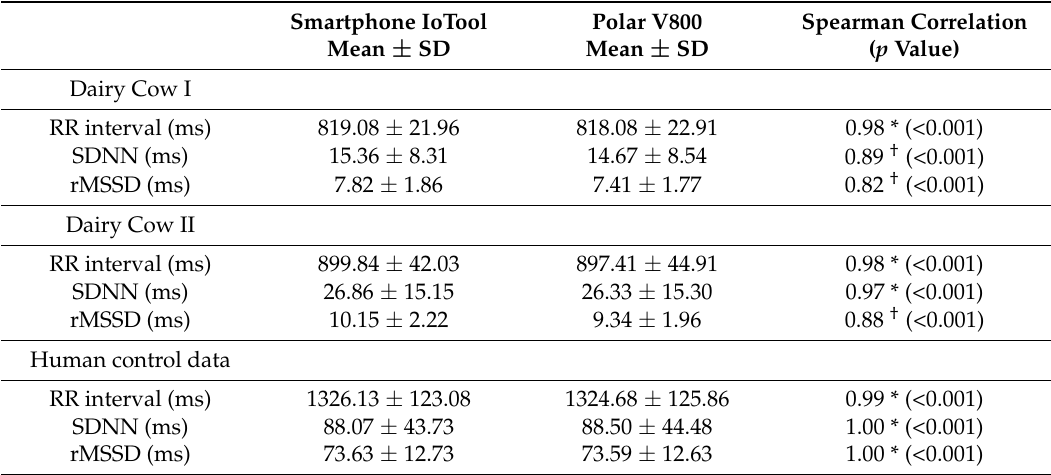
Table 1. Summary statistics of heart rate variability (HRV) parameters (mean ± SD) and validity statistics (correlation) measured via Polar watch V800 and smartphone IoTool application.